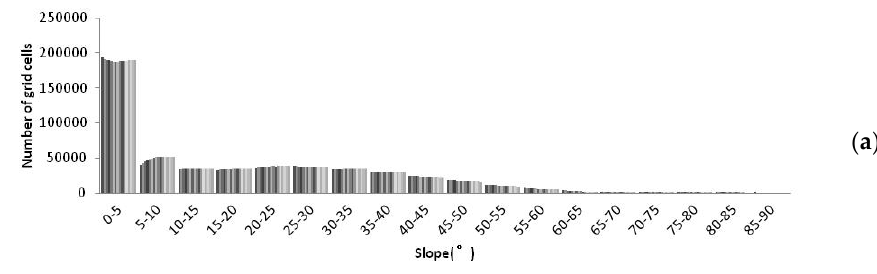
Figure 7. Plot of mean aspect with number of points in the neighbourhood in study areas 1–3 and simulated